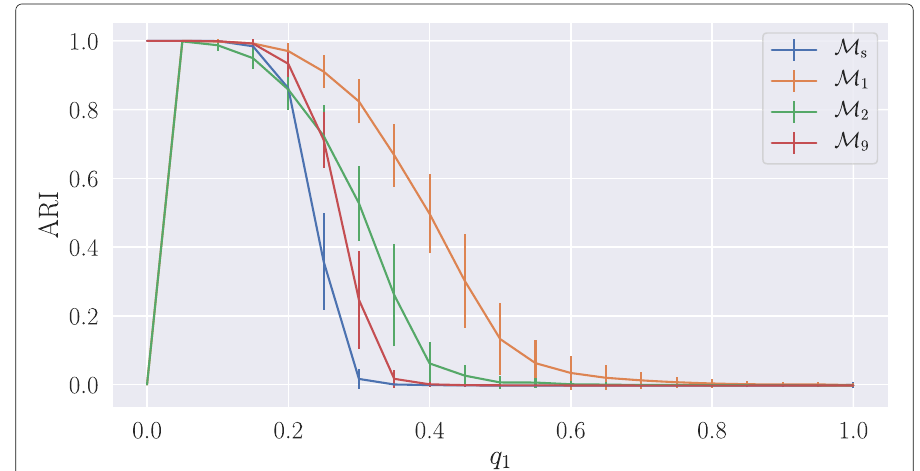
Fig. 17 Performance on Example 2 Experiment 1 using functional MAMs. We compare with the standard symmetrization M s . We perform 100 repeats, and error bars are one sample standard deviation